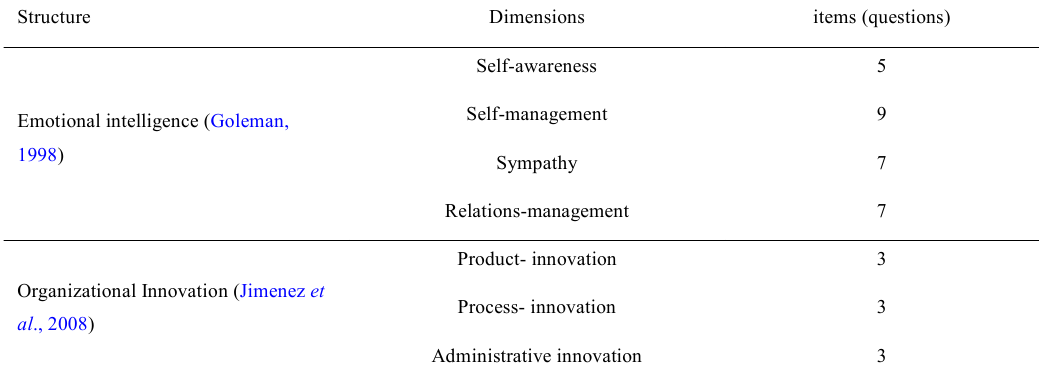
Table 1: Research structures, dimensions and